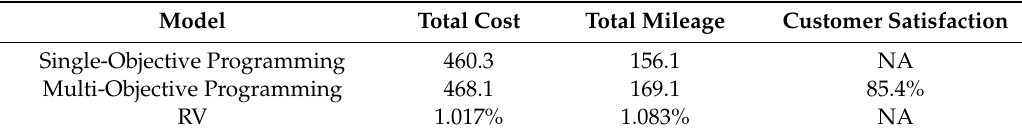
Table 6. Comparisons of total cost, total mileage, and customer satisfaction between single-objective programming and multi-objective programming.